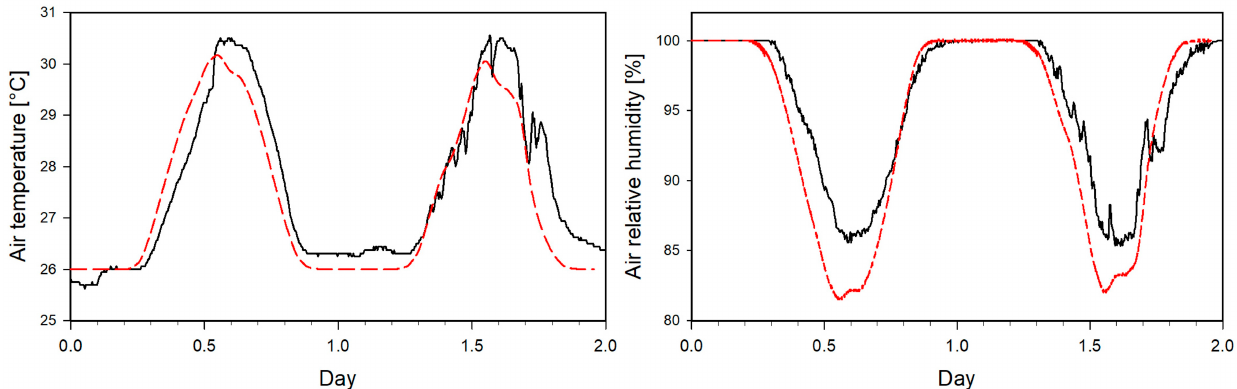
Figure 9. Measured (solid lines) and calculated (dashed lines) air temperature and relative humidity inside the underwater biosphere.